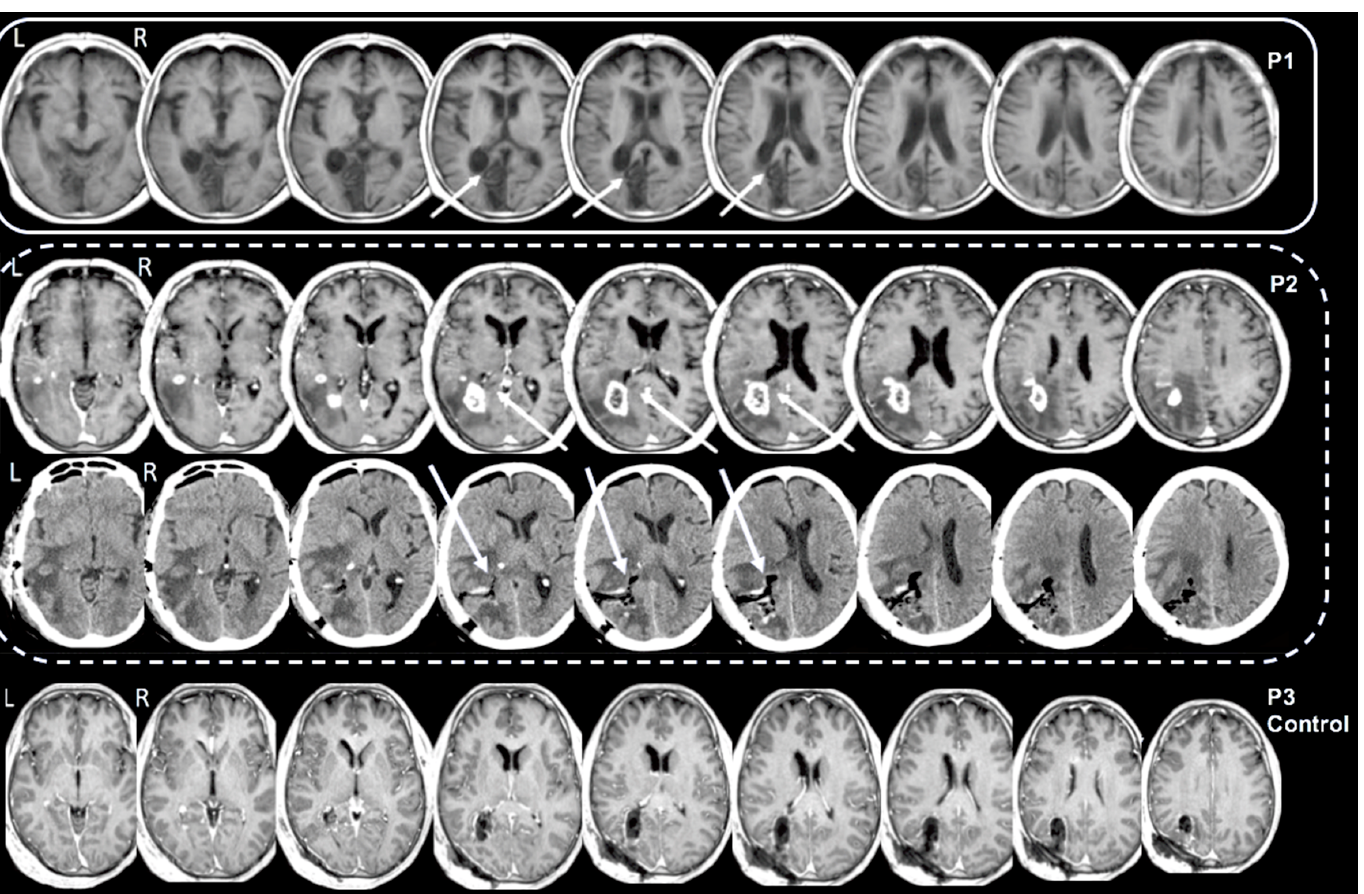
Figure 1. Patient 1 (P1) had a lesion that included the visual cortex and the forceps major continuing in the splenium of the corpus callosum. There was also a lesion in the left superior colliculus and part of the posterior left thalamus. In Patient 2 (P2, upper line), the MRI brain images pre-surgery, showed a large left posterior temporal and parieto-occipital neoplasm including the optic radiation, but the forceps major fibers were intact. Patient 2 (P2 lower line), the CT brain scan post-surgery showed the resection of the neoplasm including the optic radiation and the forceps major. The arrows indicate the brain region of the forceps major. For Patient 3 (P3 Control), the MRI brain images present a left posterior temporal and parieto-occipital resection of the neoplasm including the optic radiation, sparing the forceps major fibers. Note that none of the patients had lesions in the right hemisphere. L: left hemisphere; R: right hemisphere.